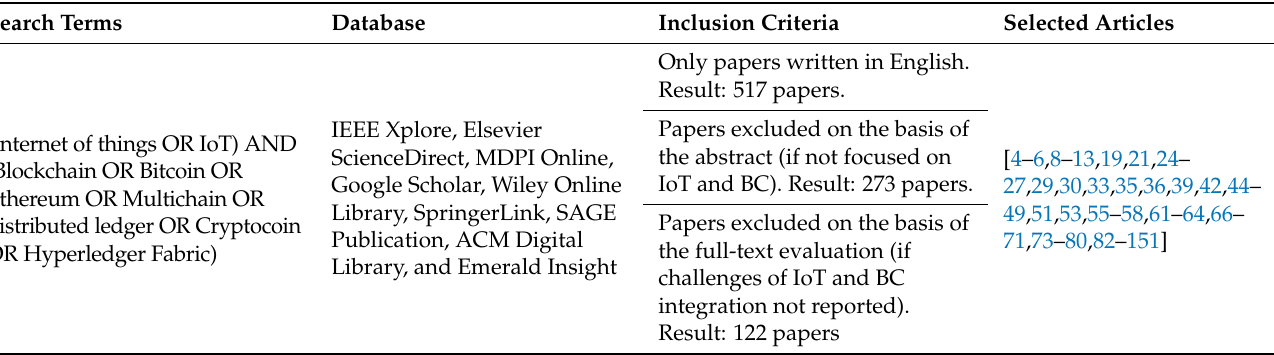
Table 5. Selected article